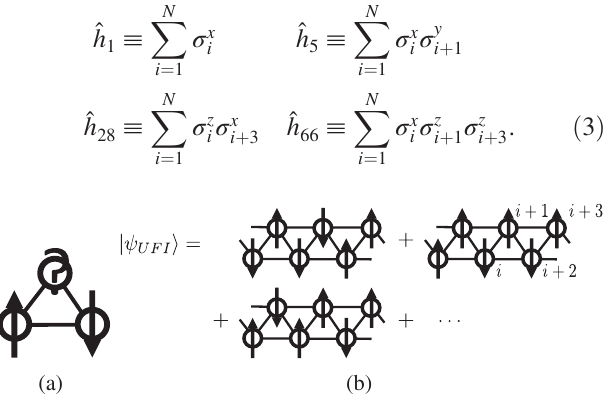
FIG. 4. (a) For a classical Ising antiferromagnetic triangle, all three bond energies cannot be simultaneously minimized, leading to a sixfold ground-state degeneracy. (b) The uniform frustrated Ising (UFI) state is a uniform superposition of the ground states of an antiferromagnetic Ising model on a lattice of triangles. In this case, we consider the UFI state on a triangular two-leg